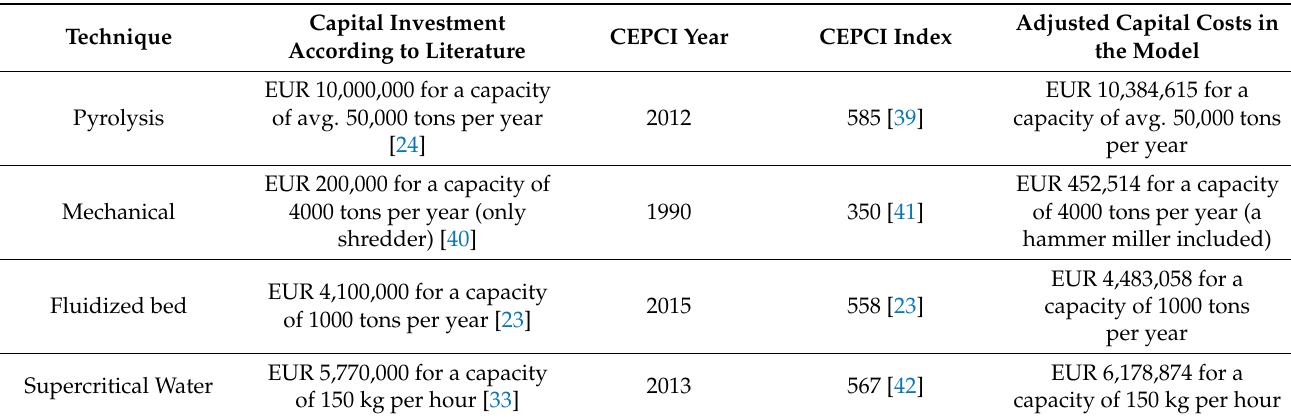
Table 3. Capital investment and used CEPCI indices for this